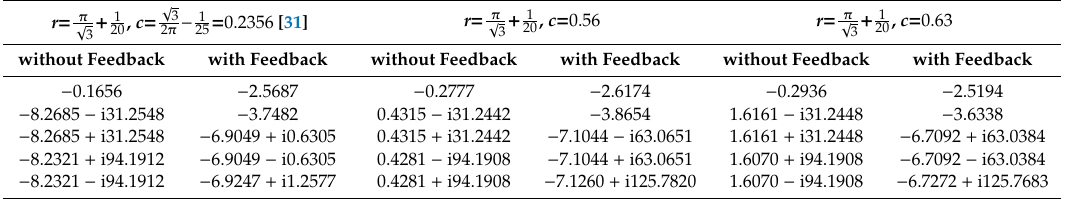
Table 1. Dominant poles of population model (Equation (40)) with di ff erent c